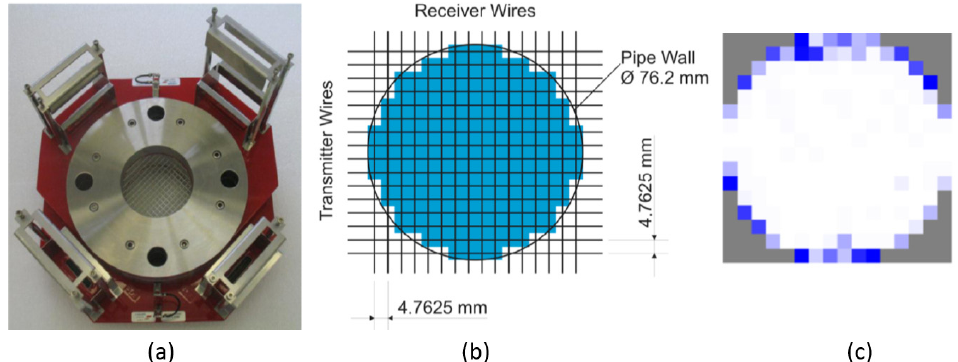
Figure 6. ( a ), An actual wire mesh sensor, adapted with permission from [144]. 2015, Elsevier, ( b ), wire distribution of the 16 × 16 sensors, adapted with permission from [145]. 2015, Elsevier, ( c ), a typical measurement frame showing the liquid phase (blue) and gas phase (white), adapted with permission from [145]. 2015, Elsevier,